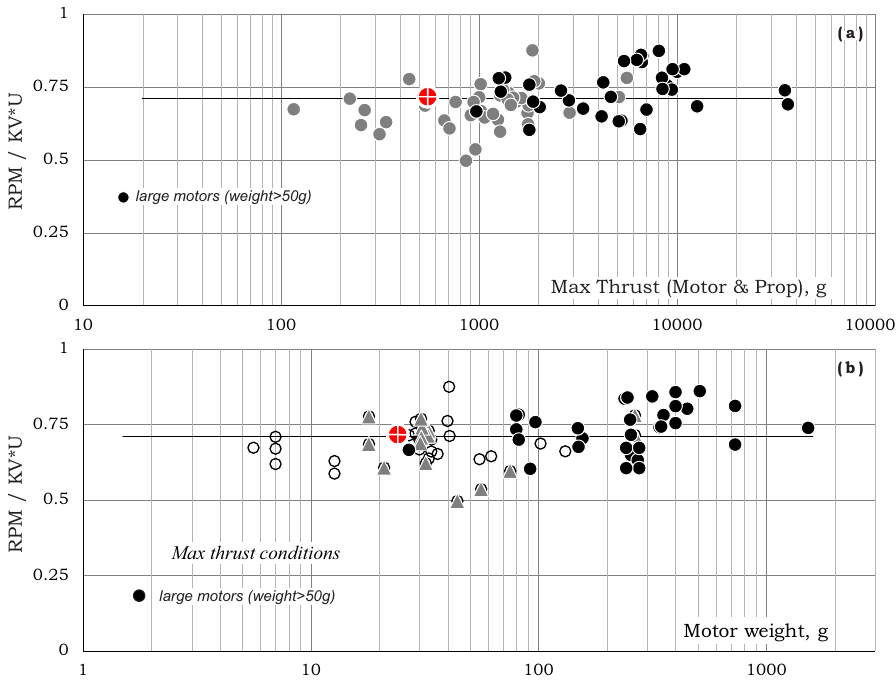
Figure 11. Ratio of RPM of loaded propeller over unloaded one, [17,18]. Equations (5), (13), (17) also show that the quantity of depend on T Max and equals 0.75.